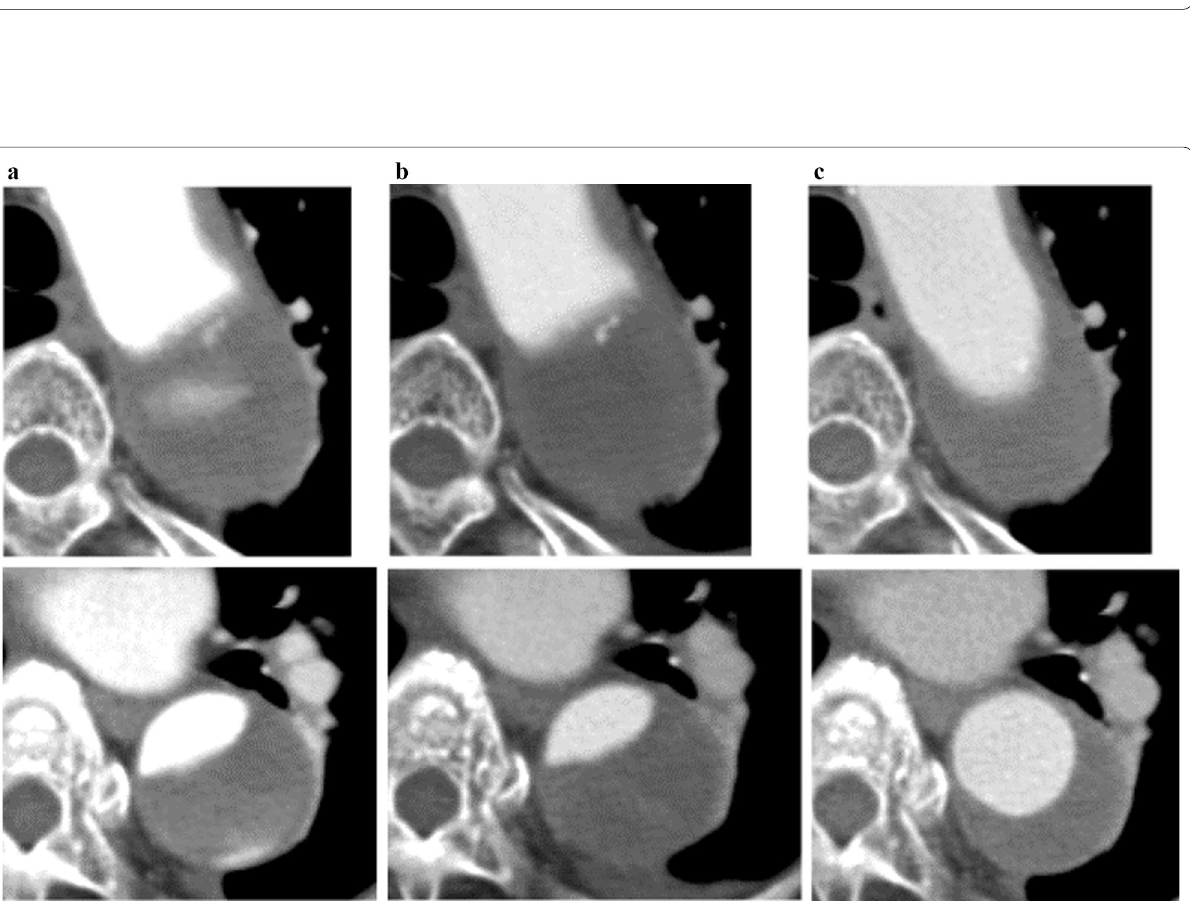
Fig. 4 Preoperative and postoperative computed tomography. a Blood flow is observed in the false lumen in preoperative CT. b In an early postoperative CT, blood flow has disappeared from the false lumen. c In a CT 1-year postoperatively, the diameter of the vessel has reduced, and the true lumen has increased in